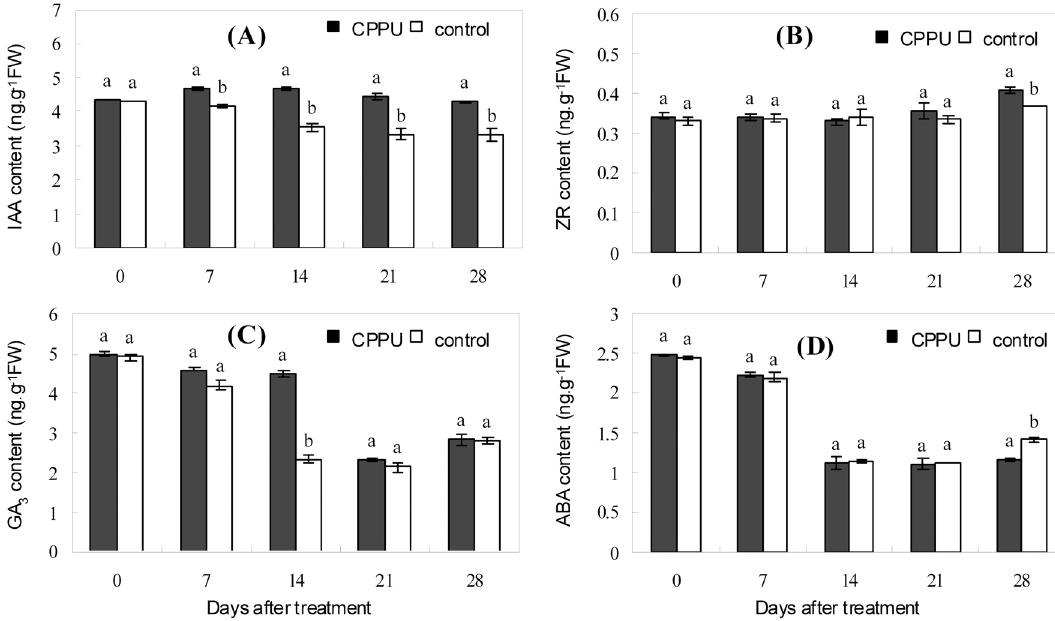
Fig 5. Effect of fruit raceme soaking with CPPU on the endogenous hormones in the husk. Different letters indicate significant difference between the treatment and the control based on t -test ( p < 0.05).